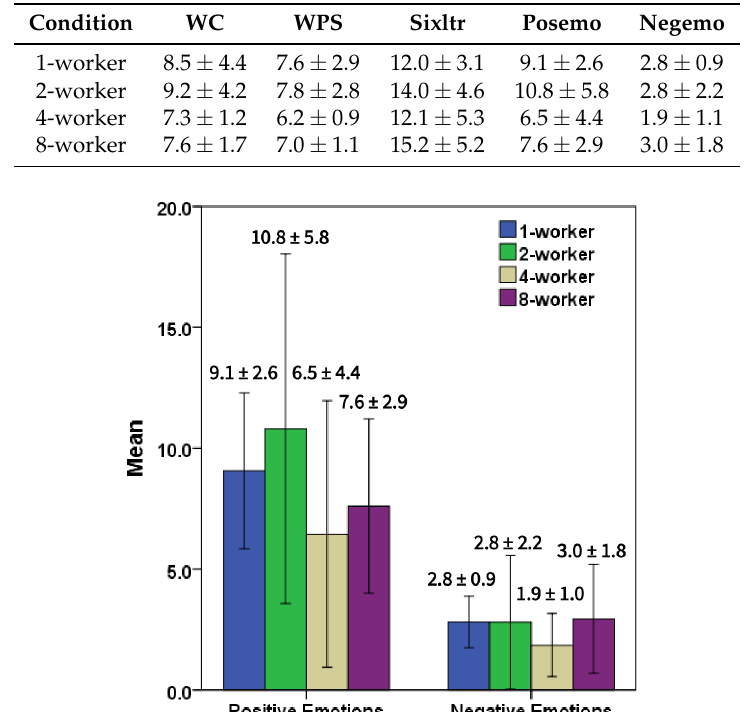
Figure 8. t -test revealed that words chosen by crowd workers contained more positive emotions than negative emotions across all conditions.